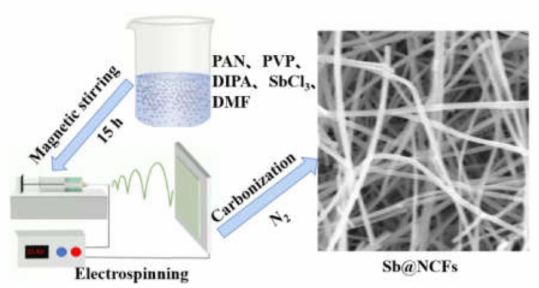
Figure 1. Synthetic illustration of the synthetic process of